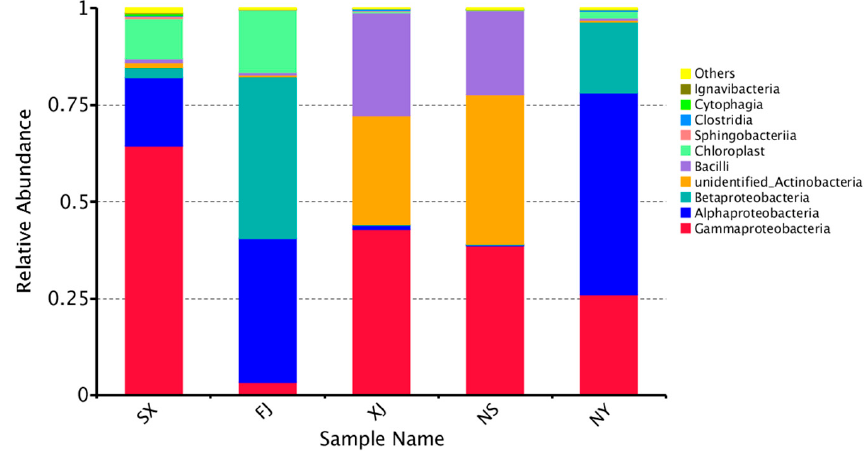
Figure 3. Relative abundance of the top 10 bacteria at the class level of taxonomy. The other classes are included as “Others.”